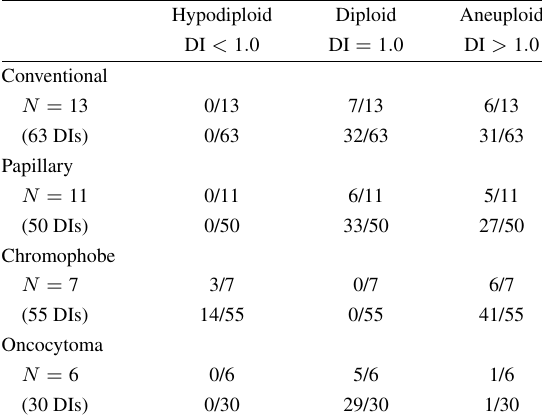
DNA index distribution in subtypes of renal